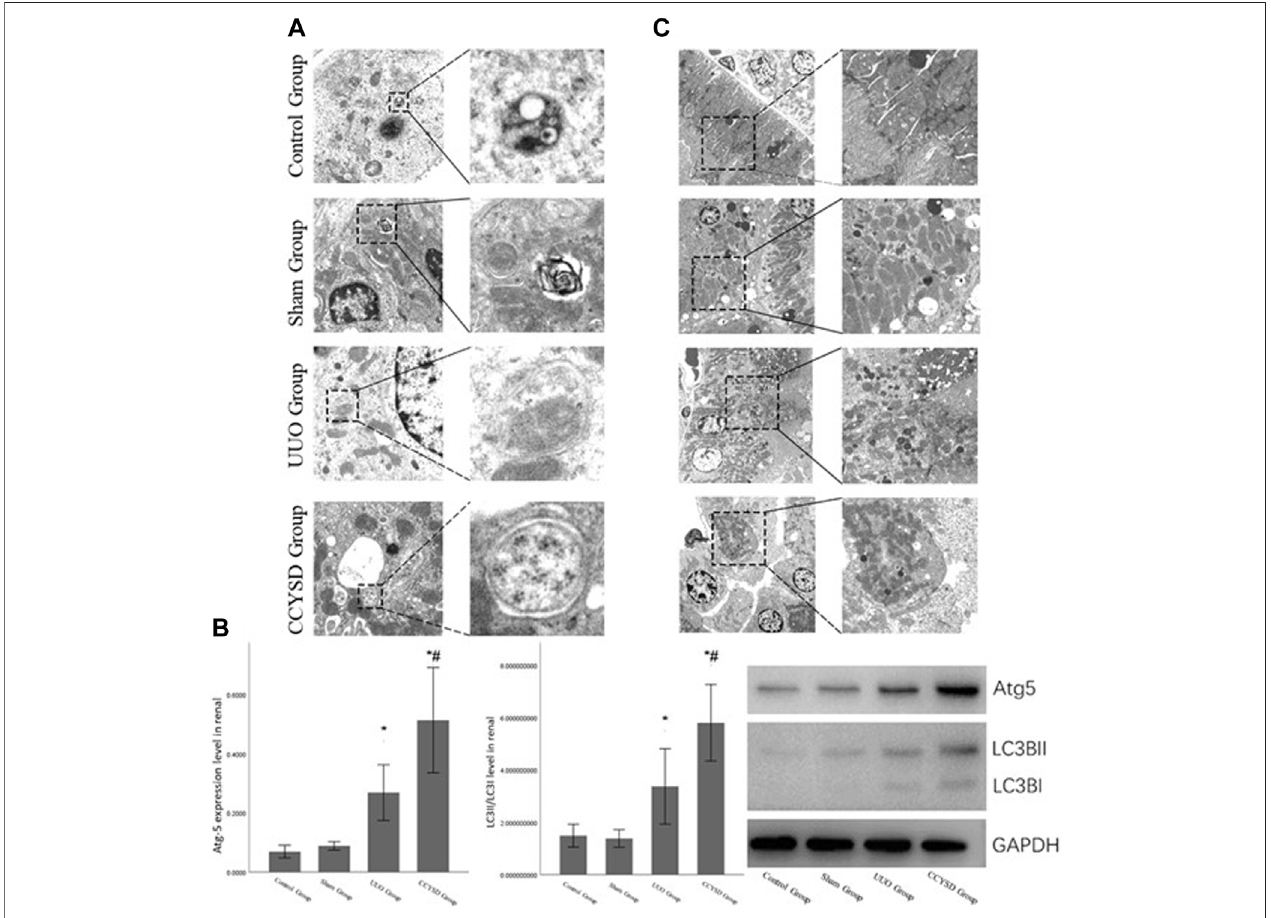
FIGURE 8 | Autophagy and mitochondrial damage in the renal tissue. (A) : autophagosomes and autophagy-lysosomes in the renal tubular epithelial cells of each group under TEM; (B) : degree of mitochondrial injury in renal tubular epithelial cells in each group under TEM; (C) :the level of Atg5 and LC3II/LC3I ratio in renal tissue; *compared with the sham group, p < 0.05; and # compared with the UUO group, p < 0.05).